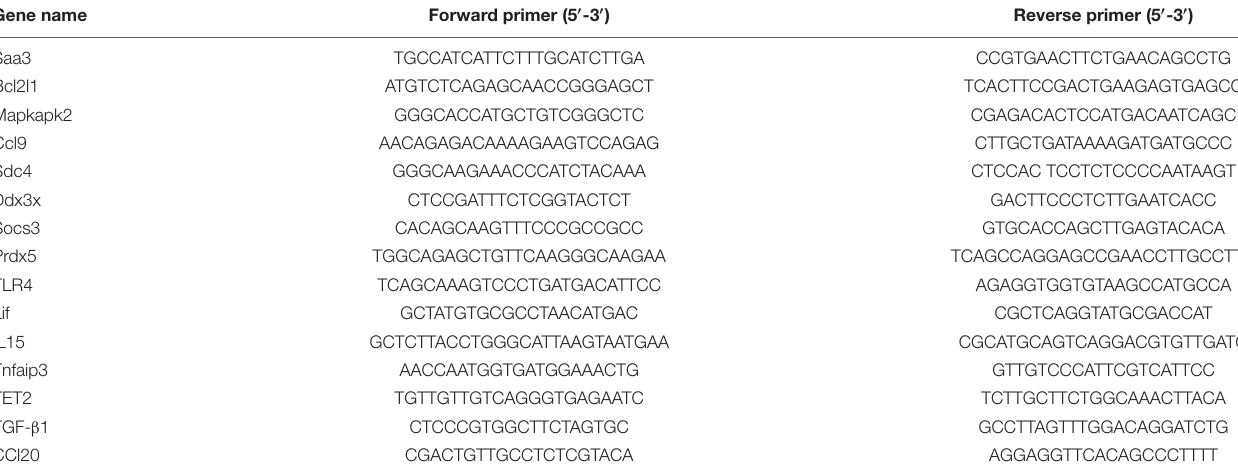
TABLE 1 | Primer sequences of real-time qPCR assay.